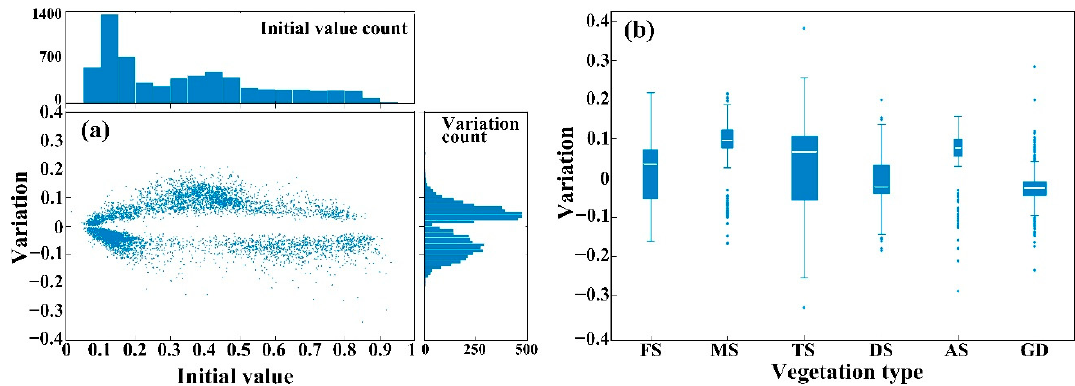
Figure 5. Relationship diagrams of initial value and variation of NDVI: ( a ) Scatter plots and histogram of initial value and variation. Initial value means the intercept of Sen’s slope linear equation and the variation is the variation of NDVI over the 34-year period (Variation = Sen’s slope × 34). ( b ) Box plot of NDVI variation under different vegetation types.